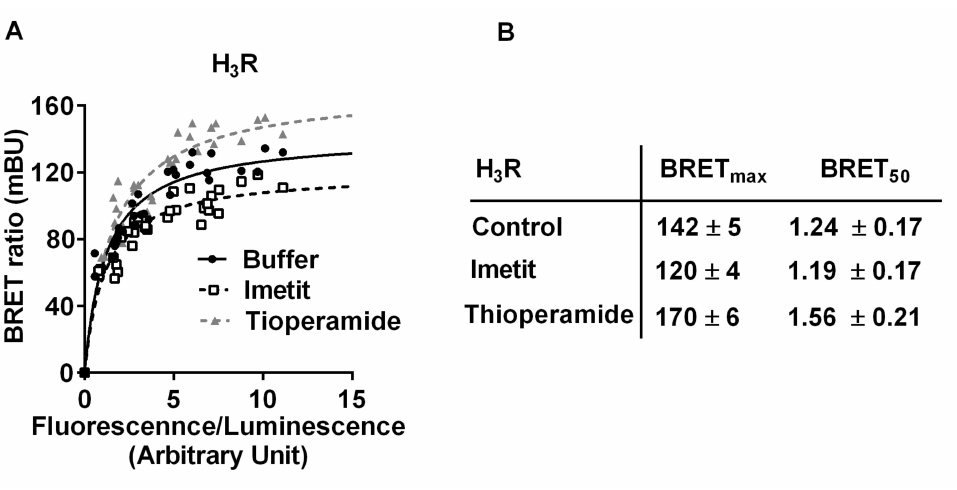
Figure 3. Effects of H 3 -receptor ligands on H 3 -receptor homodimerization in HEK 293 cells. HEK 293 cells expressing H 3 R-RLuc and H 3 R-YFP (200–500 fmol per mg protein; sub-maximal BRET) were incubated with isoproterenol (1 µ M) or H 3 ligands at fixed (100 nM) ( A ) or increasing ( B ) con- centrations. ( C ) BRET kinetic analysis of ligand-induced BRET changes in living HEK 293 cells co- transfected with H 3 R-Rluc and H 3 R-YFP. ( D ) Membranes prepared from HEK 293 cells co-expressing H 3 R-RLuc and H 3 R-YFP were incubated with various nucleotides (100 µ M). The results are represen- tative of three or four experiments carried out in triplicate. Data are expressed as a percent of BRET signals in controls. * p < 0.05; ** p < 0.01; *** p < 0.001 versus control.